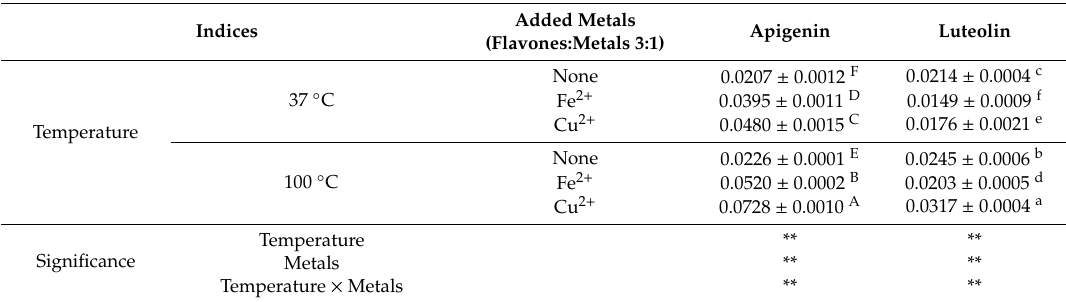
Table 1. Degradation rate constants ( k , h − 1 ) of apigenin and luteolin in solutions treated with two temperatures or added with Fe 2 + / Cu 2 + s.